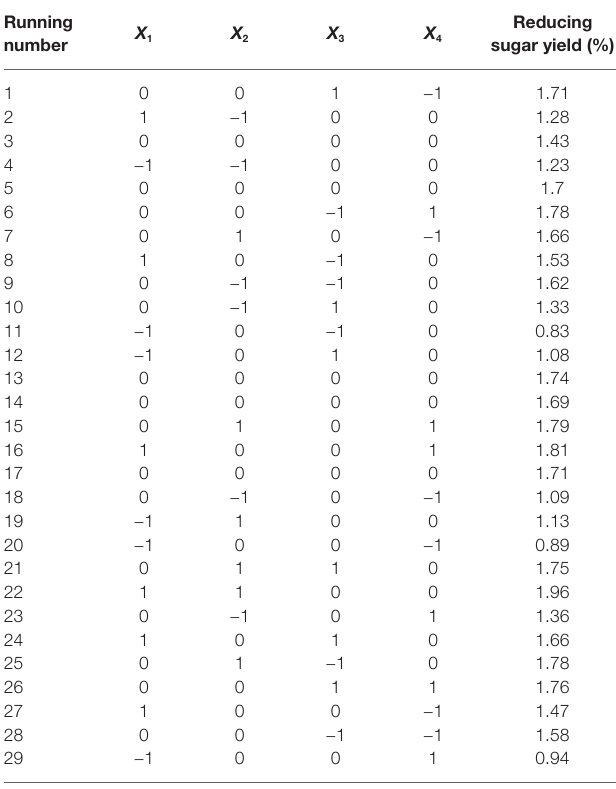
TABLE 2 | Results of the fractional factorial design matrix of rice straw degradation. Running